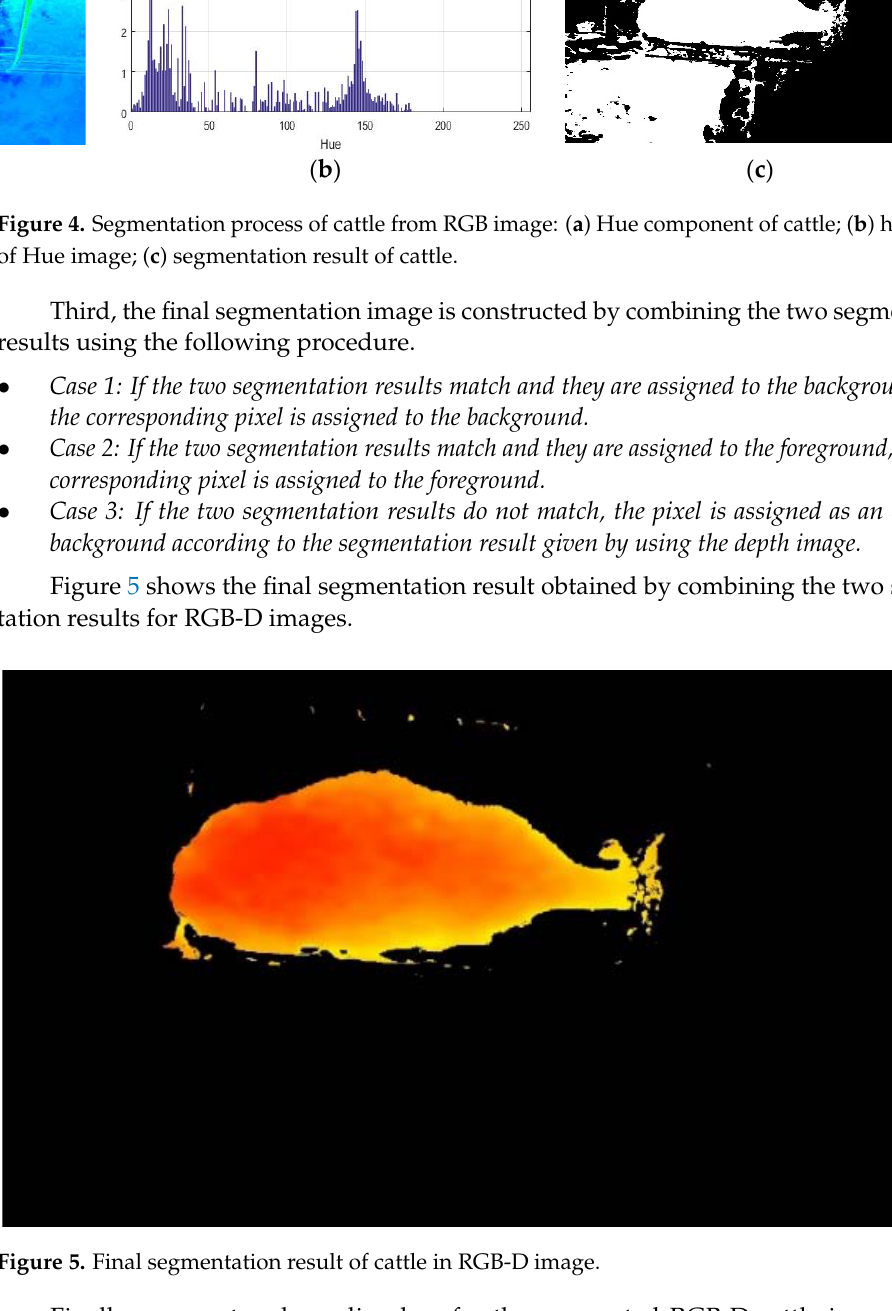
( c ) Figure 3. Segmentation process of cattle from depth image. ( a ) Depth image of cattle. ( b ) Histo ‐ gram of depth image. ( c ) Segmentation result of cattle. Second, we consider RGB color images to segment cattle. Here, we convert the RGB image to the HSV image and create a histogram for the Hue component. At this time, appropriate color ranges T (cid:2911) and T (cid:2912) are selected, and if the Hue component value is with ‐ in the selected color range, 255 is assigned; otherwise, a value of 0 is assigned. f(cid:4666)x, y(cid:4667) (cid:3404) (cid:4676)255 if T (cid:2911) (cid:3409) H(cid:4666)x, y(cid:4667) (cid:3409) T (cid:2912) 0 otherwise